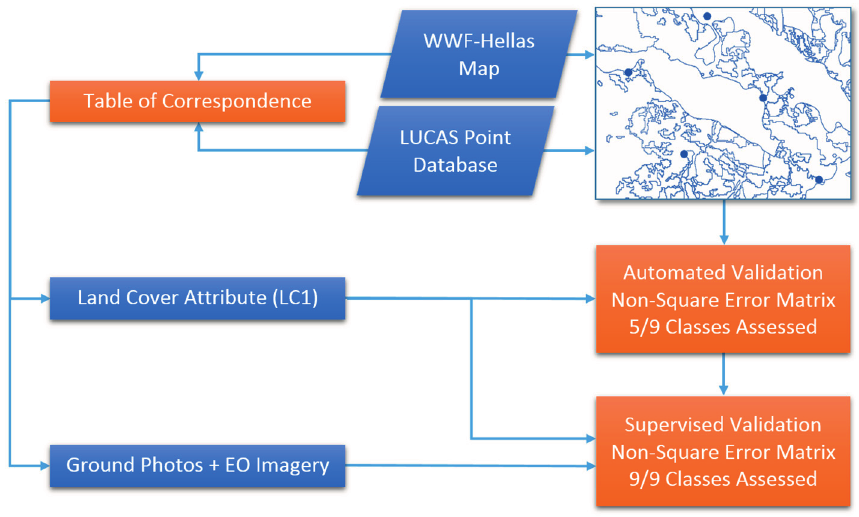
Figure 3. Depiction of the designed validation processes (automated and supervised) for the accuracy assessment of the WWF Hellas map of 2007 using the LUCAS 2009 points as main reference